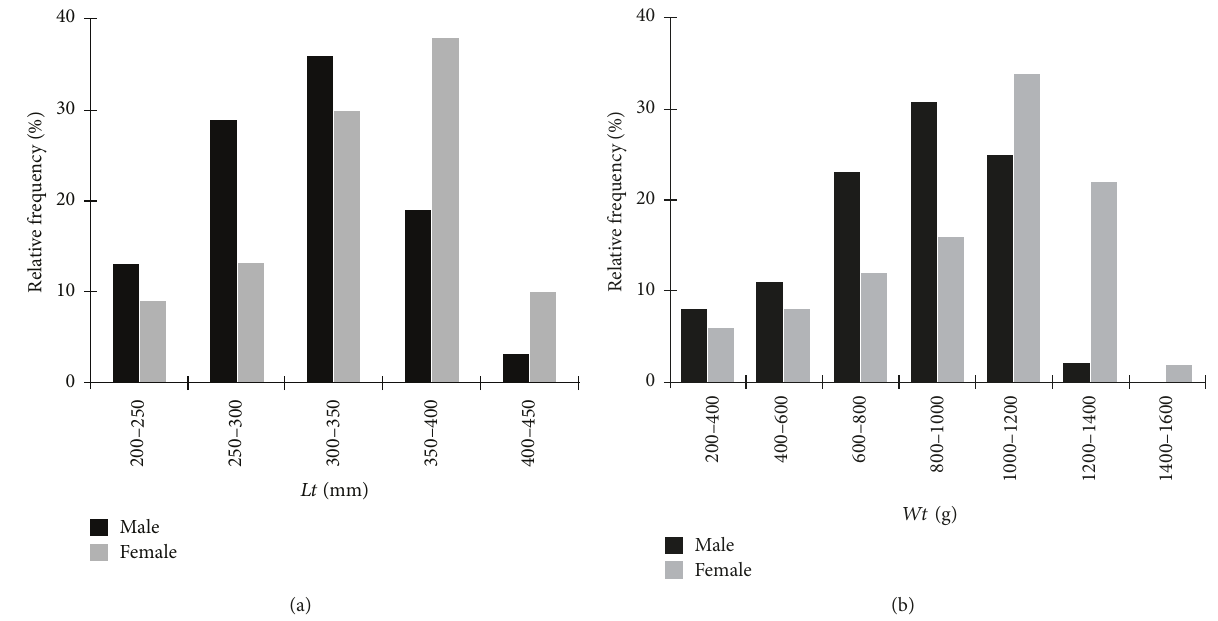
Figure 3: Population structure in total length (a) and weight (b) of S. rhombeus in the Coaracy Nunes reservoir in Ferreira Gomes, Amap´a